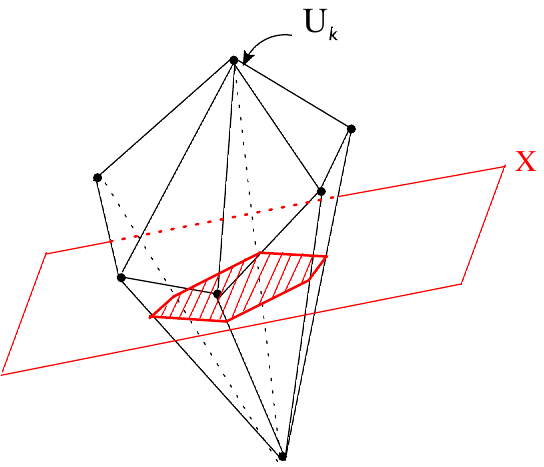
Figure 5 . The s -channel geometry at fixed k . The vector a k must live on the intersection between the cyclic plane X with the unitary polytope U cyc